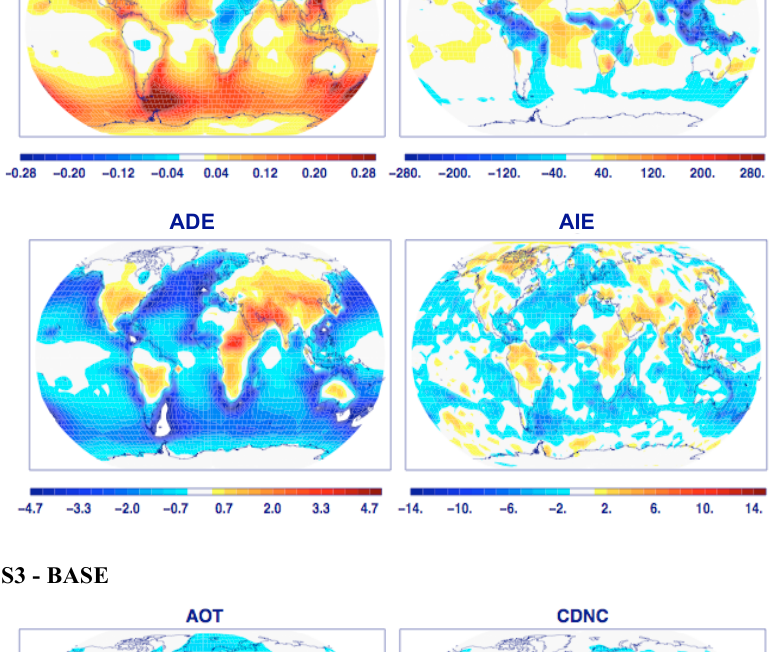
in regions distant from sources, raise the question of how the BC is distributed vertically. Figure 2 already demonstrated the large variable of BC loads among the single